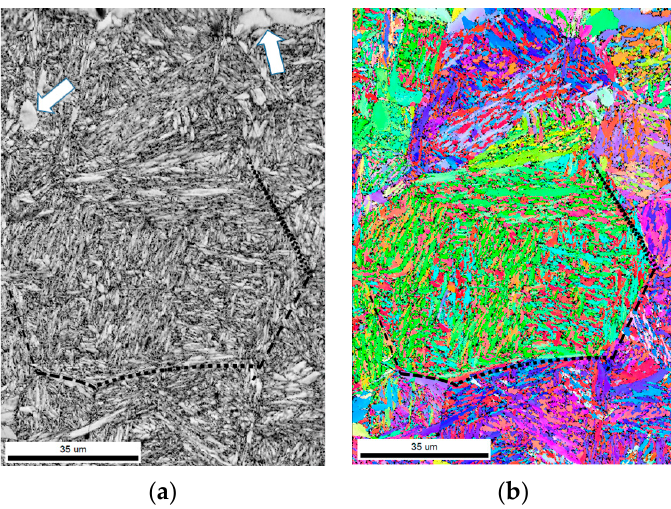
Figure 5. EBSD maps of QT specimen: ( a ) image quality (IQ) map and ( b ) IPF map.